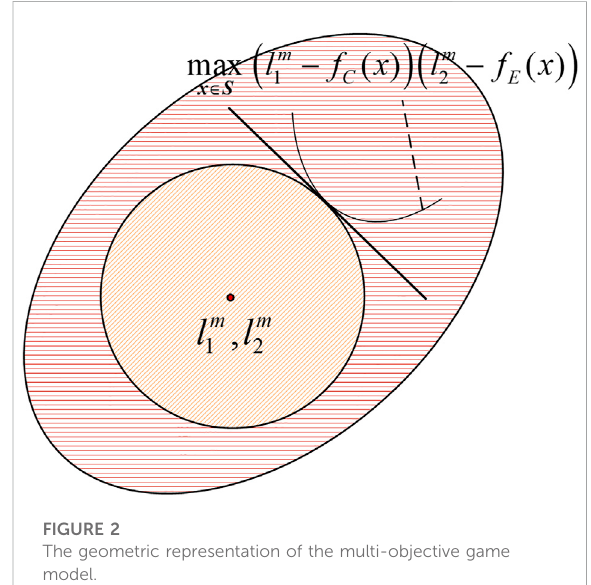
FIGURE 2 The geometric representation of the multi-objective game